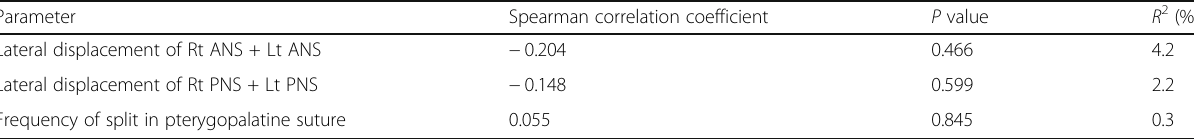
Table 4 Analysis of correlation between age and parameters of suture opening Parameter